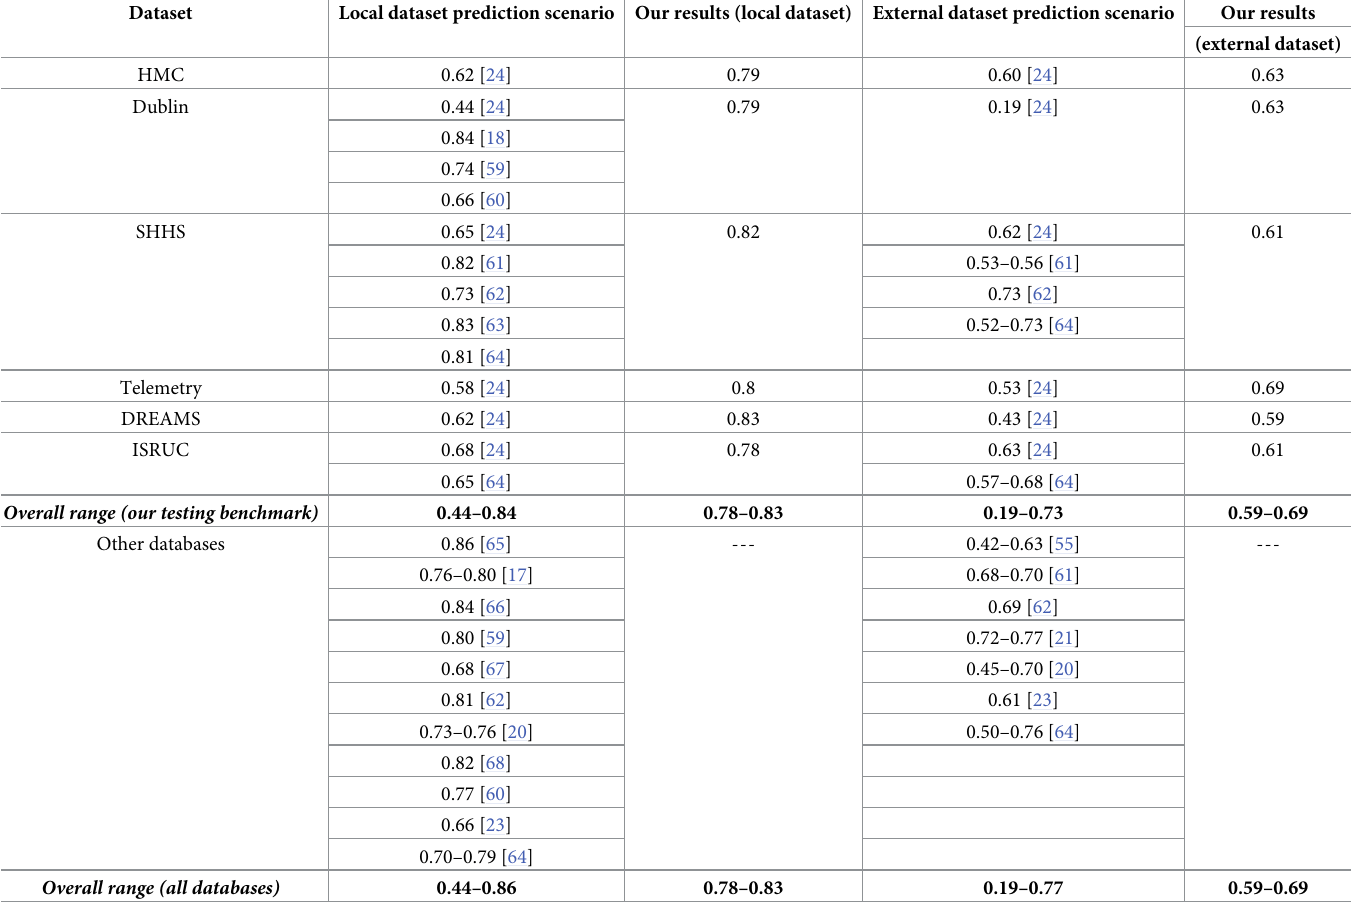
Table 6. Indices of automatic scoring agreement reported in the literature in comparison with the results achieved by the proposed deep-learning approach.